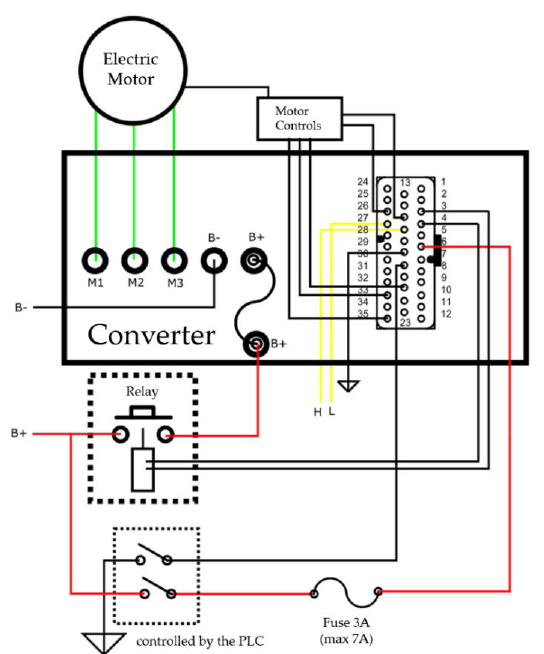
Figure 4. Layout of connections between the electric motor and the converter.